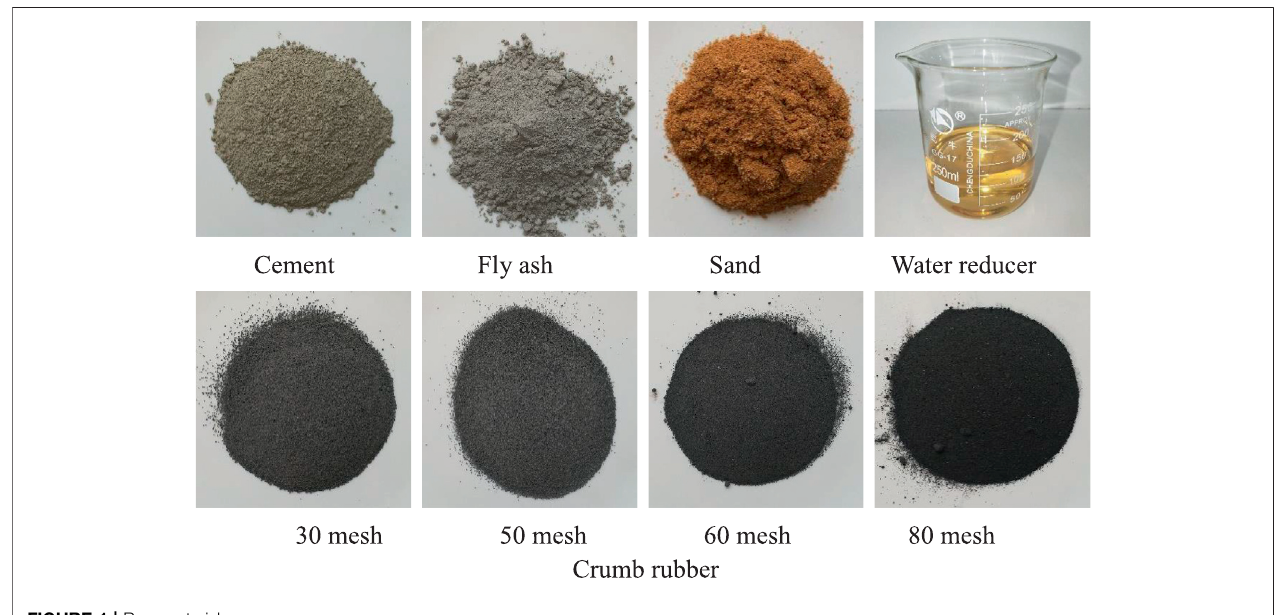
FIGURE 1 | Raw material.